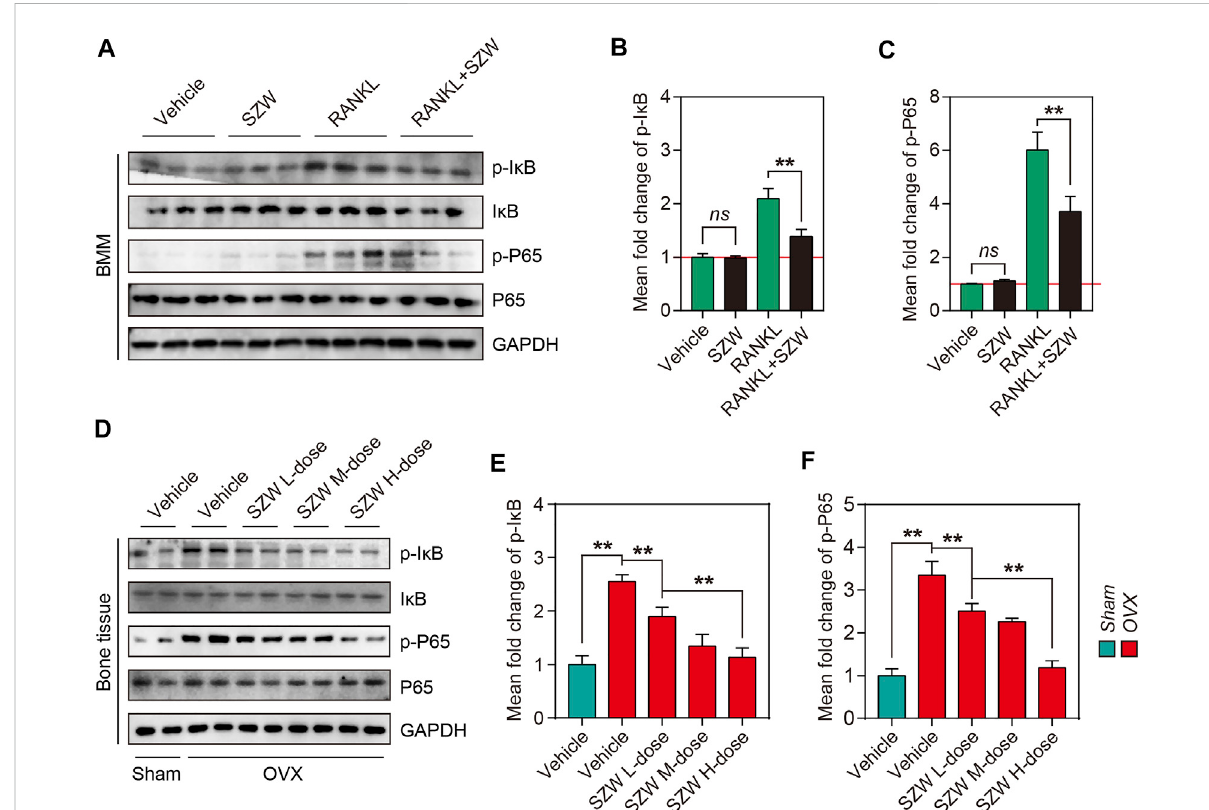
FIGURE 5 SZW suppressed NF- κ B pathway activation in vivo and in vitro. Primary BMM cells were isolated from bone tissue of C57BL/6 mice, and BMMs were induced to differentiate into osteoclast precursors using M-CSF, and then treated with the indicated treatments (A) Representative western blottingimagesshowingp-I κ B,I κ B,p-P65,andP65expressionlevelsinBMMs (B) Themeanfoldchangeofp-I κ B/I κ Bratio (C) Themeanfoldchange of p-P65/P65 ratio (D) Representative western blotting images showing p-I κ B, I κ B, p-P65, and P65 expression in bone tissue of rats (E) The mean fold change of p-I κ B/I κ B ratio in rats (F) The mean fold change of p-P65/P65 ratio in rats. Data are expressed as the mean ± SEM (n = 3). p p < 0.05, pp p <